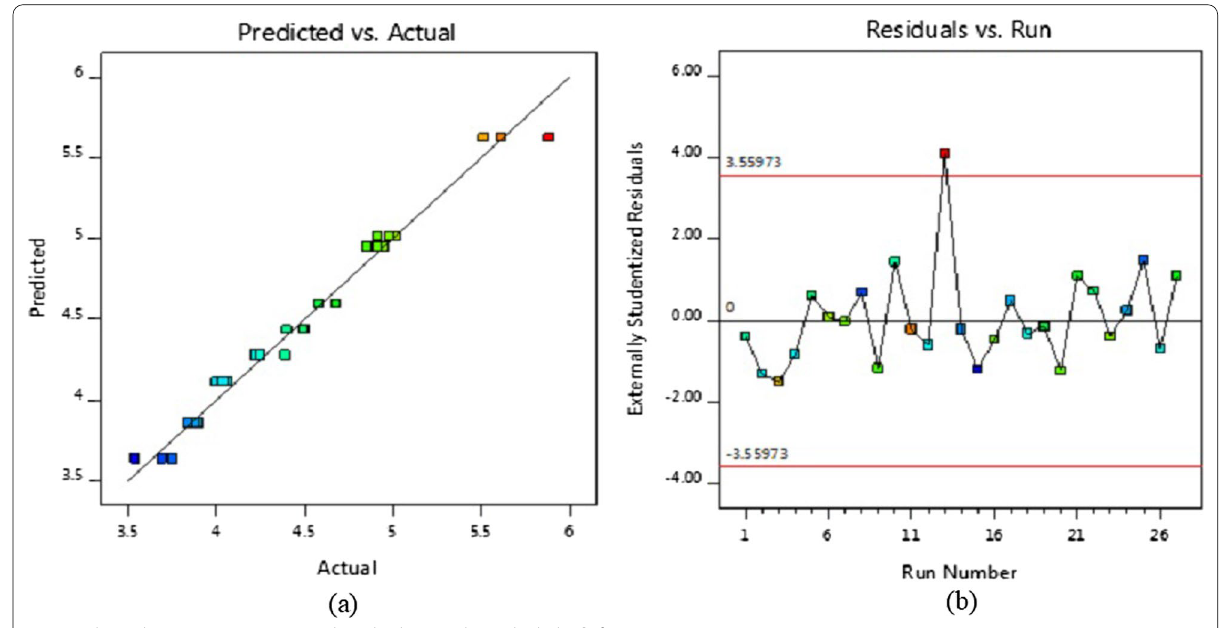
Fig. 2 Plot a showing true versus predicted values, with residual plot b for response